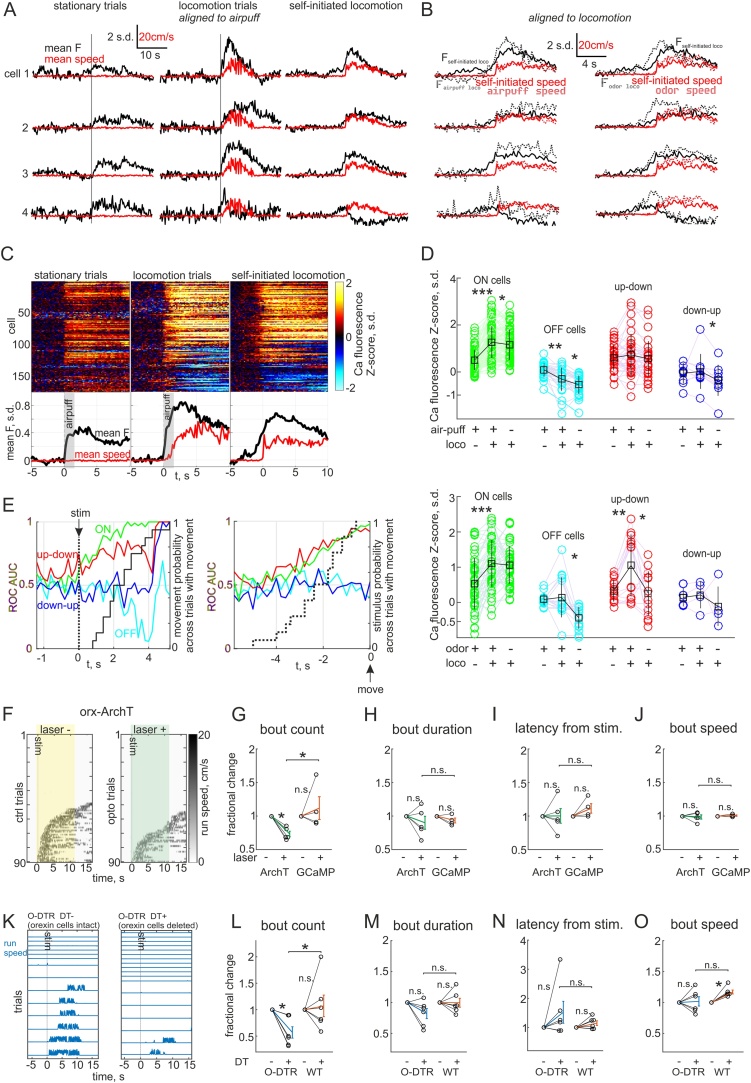
HONs mediate a rapid sensorimotor transformation.A, Example cells responding to tactile stimulus (2 s airpuff 15 psi to base of tail) while mouse was stationary (left) and when the airpuff triggered movement (middle). Also shown activity profiles during self-paced movement without sensory stimuli (right). B, Expanded view of self-paced traces from A (black and red) and stimulus triggered movement (magenta, airpuff on left; social odor on right, consisting of female urine odor presentation for 0.5 s) and response (blue, airpuff on left; social odor on right) aligned to the onset of movement. C, Activity of all recorded cells in response to airpuff while mice were stationary (left, averaged across) and when movement was triggered (middle). Also shown activity profiles during self-paced movement without sensory stimuli (right). Bottom black traces are averages across all cells and red traces movement speed. D, Mean responses measured from an analysis window 1−4 s after sensory stimulus onset (or locomotion onset for self-paced locomotion) in airpuff (above, mean ± s.d. values in black: ON 0.50 ± 0.42, 1.27 ± 0.67, 1.16 ± 0.63; OFF 0.09 ± 0.29, −0.31 ± 0.50, −0.54 ± 0.40; up-down 0.61 ± 0.53, 0.73 ± 0.87, 0.56 ± 0.73; down-up −0.05 ± 0.43, 0.02 ± 0.73, −0.36 ± 0.65) and odor presentation (below, mean ± s.d. values in black: ON 0.53 ± 0.73, 1.11 ± 0.67, 1.06 ± 0.54; OFF 0.08 ± 0.16, 0.14 ± 0.56, −0.44 ± 0.30; up-down 0.33 ± 0.30, 1.05 ± 0.87, 0.26 ± 0.62; down-up 0.14 ± 0.25, 0.21 ± 0.37, −0.11 ± 0.55). * P < 0.025, ** P < 0.001, *** P < 10−8. E, Evolution of area under the curve receiver operating characteristic calculated from cell activity data in airpuff stimulation trials where locomotion had not yet started (left panel). Black continuous plot is the cumulative probability distribution of locomotion onsets from trials with movement (16/48). Right panel is ROC AUC calculated from trials aligned to locomotion onset instead of stimulus. Black dashed curve is the cumulative probability distribution of stimuli across trials with movement. F, Example recordings of treadmill speed during sensory evoked running in head-fixed orexin-ArchT animals with laser turned on 0.5 s before stimulus (left) and without laser (right). G–J, Averaged movement bout statistics normalized to baseline from each mouse (5 ArchT mice and 4 control mice), tested by paired Student’s t-test (*: P < 0.05). G, number of movement bouts (ArchT 73 ± 4 %; GCaMP 112 ± 17 %); H, duration of bouts (ArchT 90 ± 10 %; GCaMP 93 ± 4 %); I, latency from sensory stimulus to run bout (ArchT 100 ± 11 %; GCaMP 111 ± 7 %); H, average speed of bouts (ArchT 99 ± 3 %; GCaMP 101 ± 1 %). K, Representative treadmill speed recordings during sensory evoked running from head-fixed O-DTR mice after (left) and before (right) DT administration. L–O, Averaged movement bout statistics normalized to baseline from each cohort (6 mice/cohort), tested by paired Student’s t-test (*: P < 0.05). L, number of movement bouts (O-DTR DT + 50 ± 10 %; WT DT + 107 ± 21 %); M, duration of bouts (O-DTR DT + 88 ± 8 %; WT DT + 100 ± 7 %); N, latency from sensory stimulus to run bout (O-DTR DT + 165 ± 44 %; WT DT + 115 ± 8 %); O, average speed of bouts (O-DTR DT + 100 ± 9 %; WT DT + 117 ± 3 %).